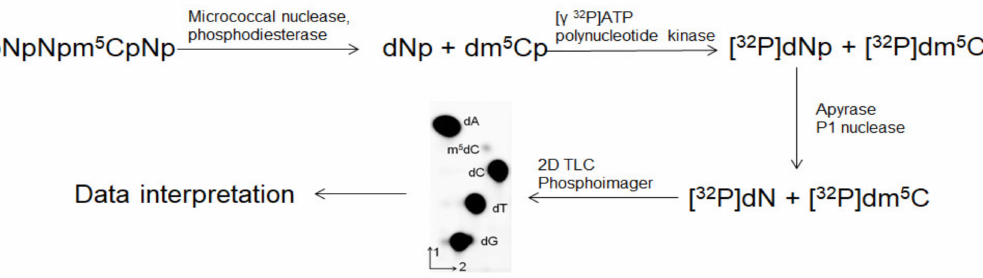
Figure 9. Analysis of m 5 C in